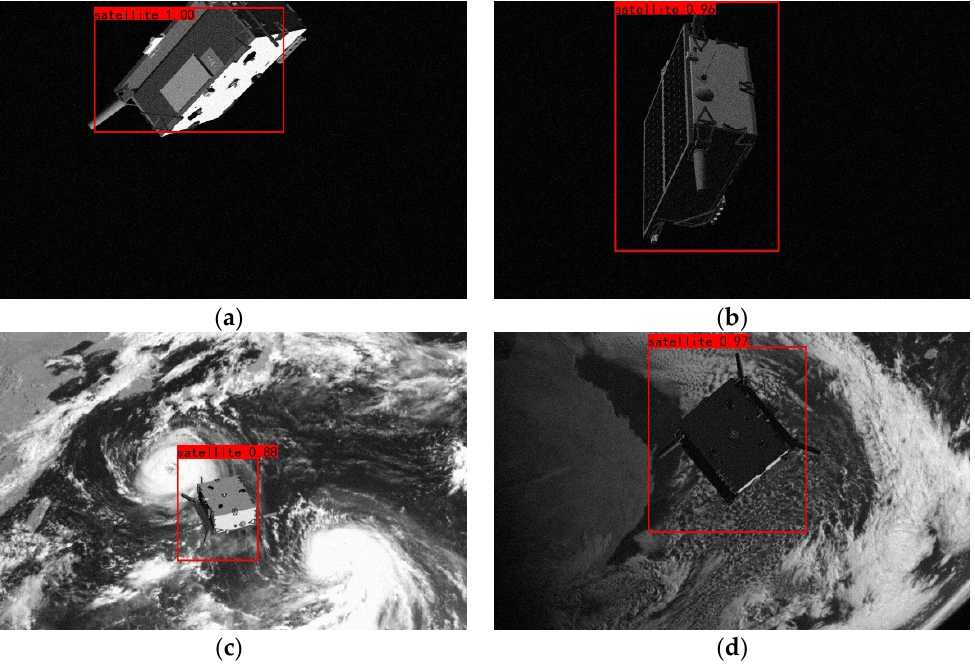
Figure 15. Object detection results of non-cooperative targets. ( a ) Deep space background intense lighting. ( b ) Dark background dark lighting. ( c ) Earth background strong lighting. ( d ) Earth background dark lighting.